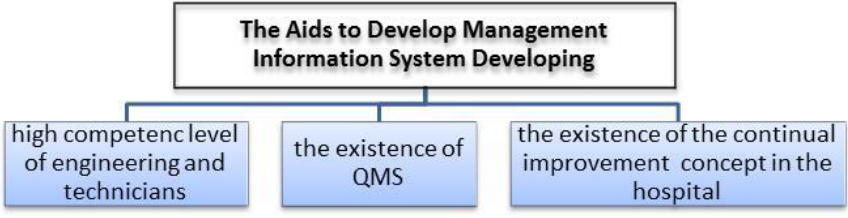
Fig. 18. Management information system developing